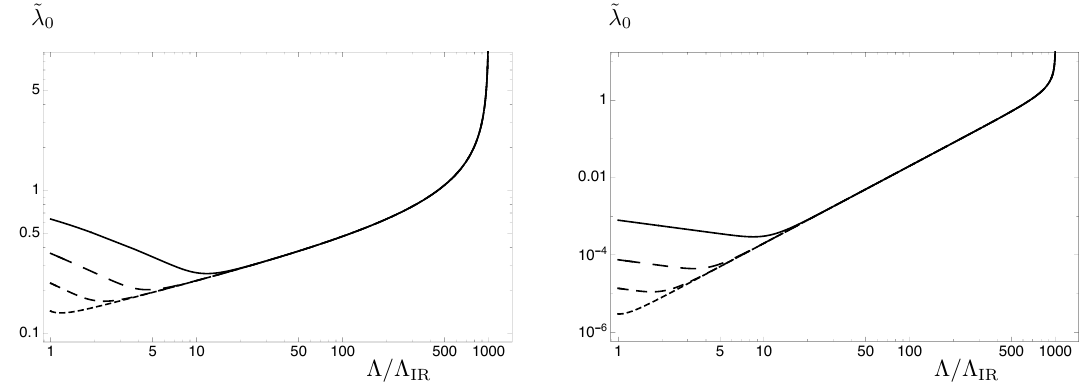
Figure 11 . Model I. The left panel shows the effective scaling dimension ∆ (eff) energy scale Λ , for ∆ = 2 . 5 , x F = 1 , 3 , 4 . 7 , 4 . 9 (short-dashed, dashed, long-dashed, solid lines), and two choices ∆ R = 1 . 6 , 3 . 5 (in blue, black). The right panel shows the maximum IR value ˜ λ (max) function of x F , for ∆ = 2 . 5 , Λ UV = 10 3 , and ∆ R = 1 . 7 , 2 . 3 , 2 . 6 , 3 (short-dashed, dashed, long-dashed, Λ IR solid lines).